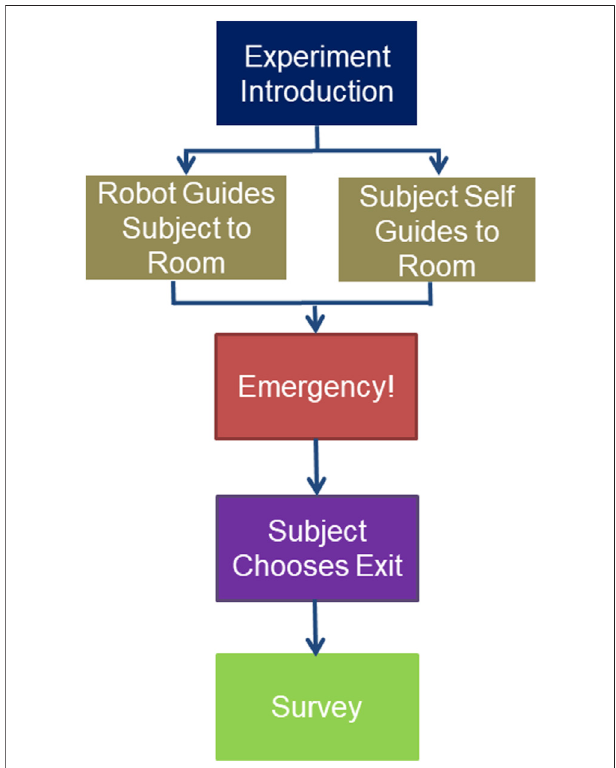
FIGURE 7 | The general procedure for robot-guided emergency evacuation experiments. The subject is introduced to the robot. The robot guides the subject to a meeting room or the subject self-guides to a meeting room. An emergency occurs. The robot approaches subject asking the subject if they would like to follow the robot to an exit. After reaching (or not reaching) the exit the subject completes a survey.